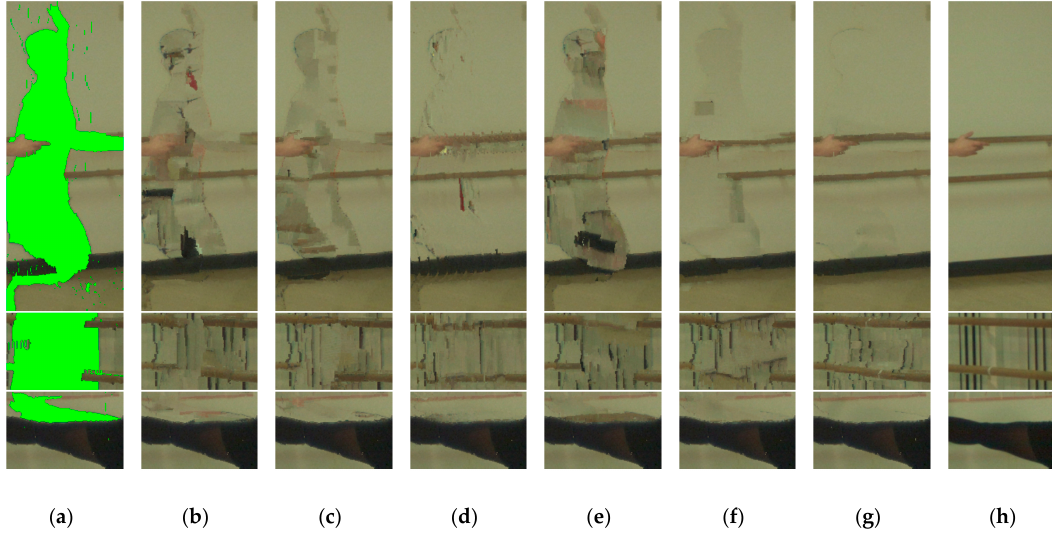
Figure 13. Disocclusion filling results in the case of large baseline: ( a ) Disocclusions after DIBR; ( b ) Criminisi’s method; ( c ) Daribo’s method; ( d ) Lei’s method; ( e ) Oliveira’s method; ( f ) Kao’s method; ( g ) the proposed method; and ( h ) ground truth.